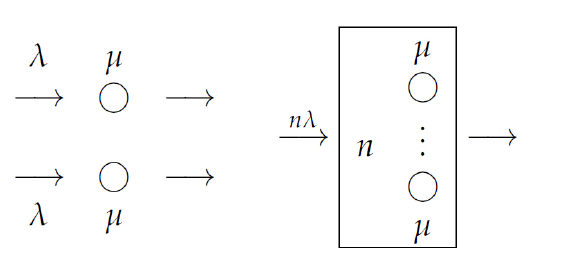
Figure 2. n isolated M | M | 1 | 0 systems ( left ), aggregated M | M | n | 0 system ( right ). (cid:98) b n